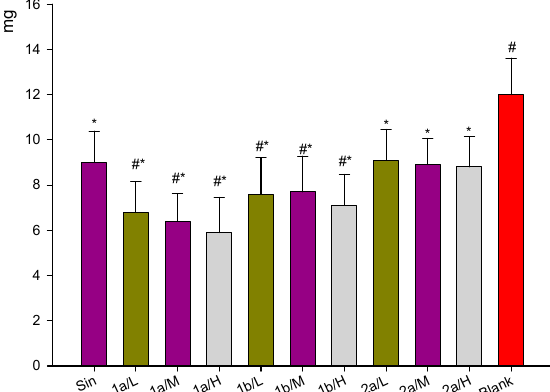
Figure 7. Dimethylbenzene-induced mouse ear oedema was reduced upon treatment with Sin, 1a , 1b or 2a derivatives. Mice were topically treated with Sin or one of its 1a – 2a derivatives for 3 days. Ear oedema was then induced by topical administration of dimethylbenzene. Sinomenine and its derivatives significantly reduced the dimethylbenzene -induced mouse ear oedema. Data are expressed as mean ± SD ( n = 10). * p < 0.05 vs. vehicle (blank), # p < 0.05 vs. Sin group. High-dose group: 32.500 mg/kg, middle dose group: 3.250 mg/kg, low dose group: 0.325 mg/kg, Sin group dose: 3.250 mg/kg. Where Sin’s dose (3.250 mg/kg) is equivalent clinical often dose of man.